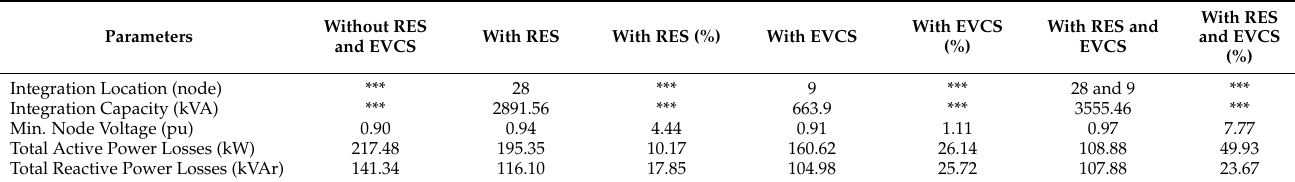
Table 4. Comparison of parameters with RES and EVCS and without RES and EVCS.